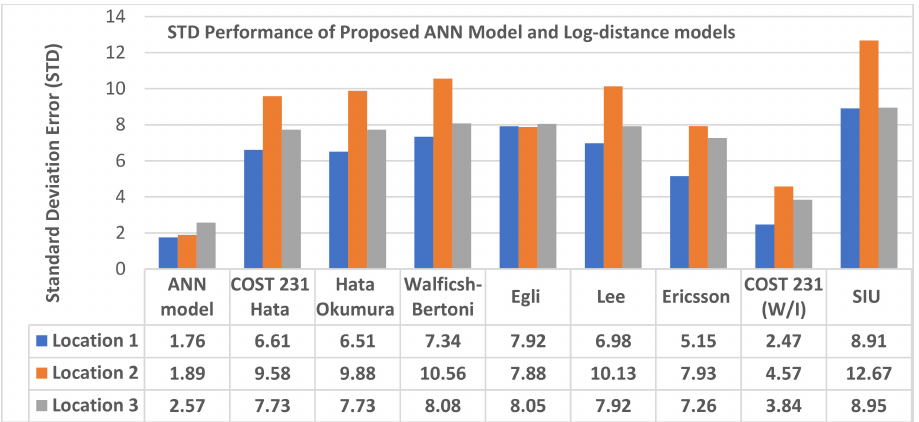
Figure 23. A comparison of standard deviation error statistics between the proposed ANN and log-distance models on measured path loss in site locations 1, 2 and